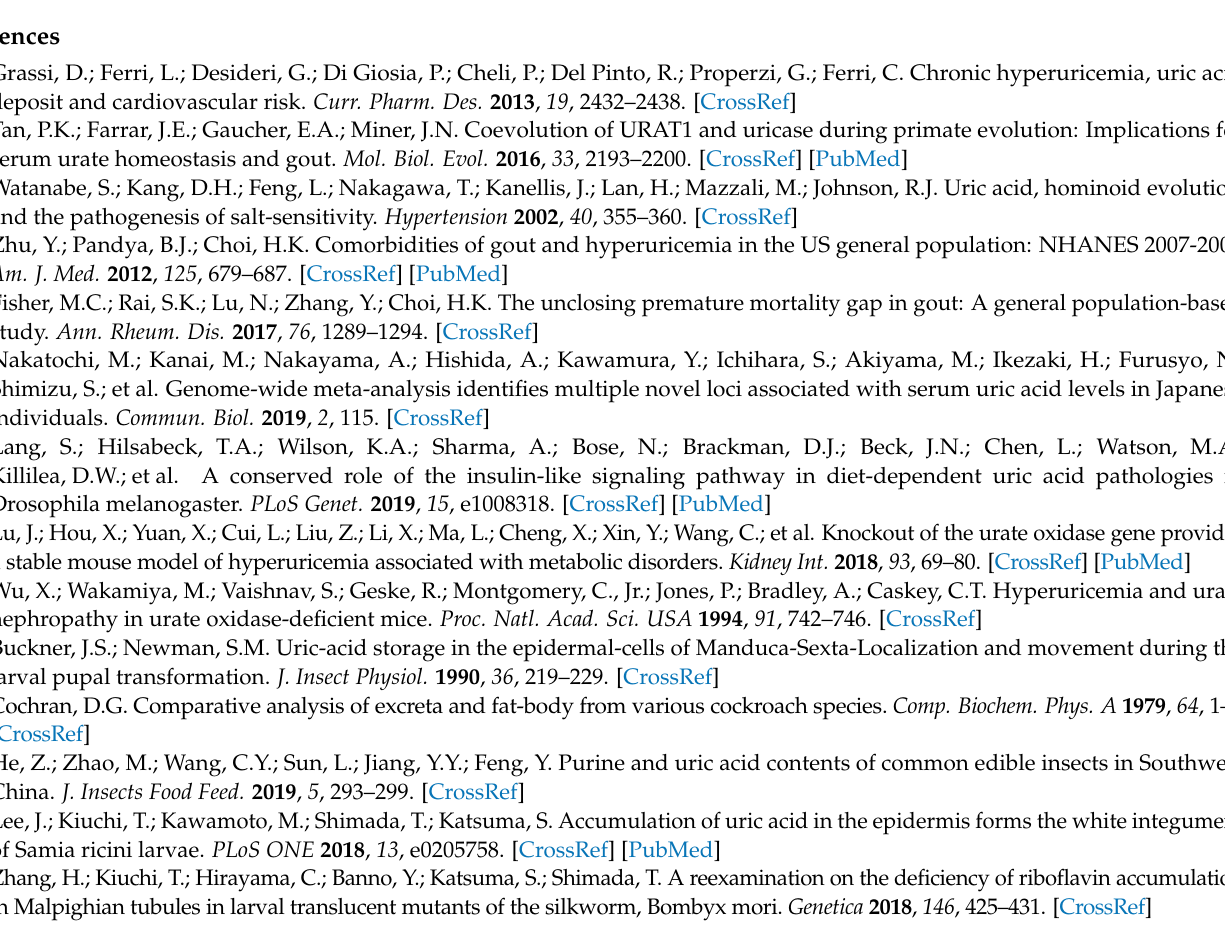
Figure S6: CRISPR/Cas9 induced mutagenesis of BmABCG5 mutant, Table S1: Primers used in this work, Table S2: Silkworm homologous gene